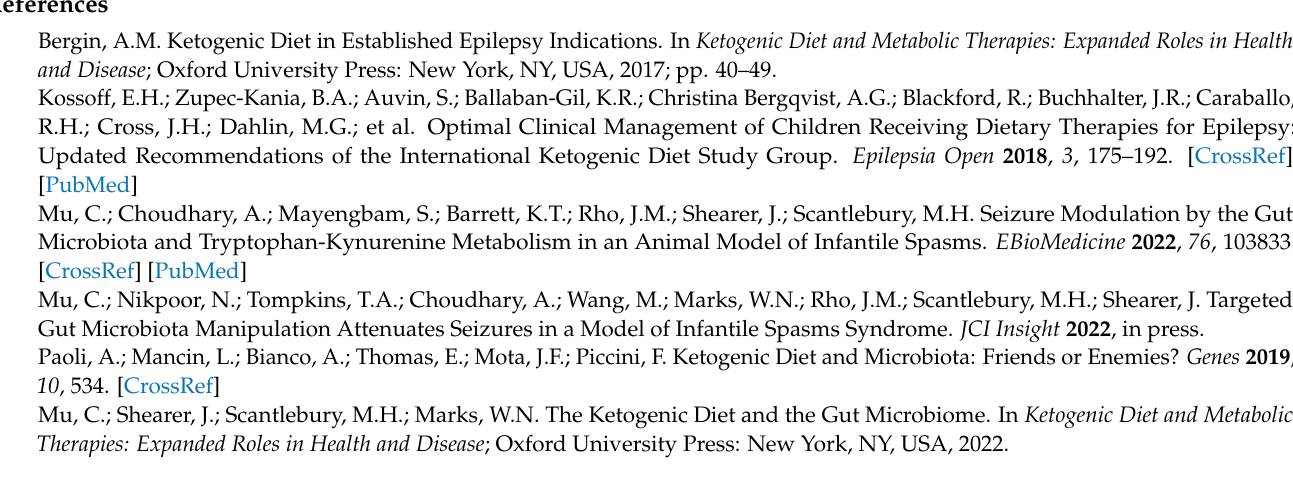
Table S3: The average relative abundances of operational taxonomic units detected in the present